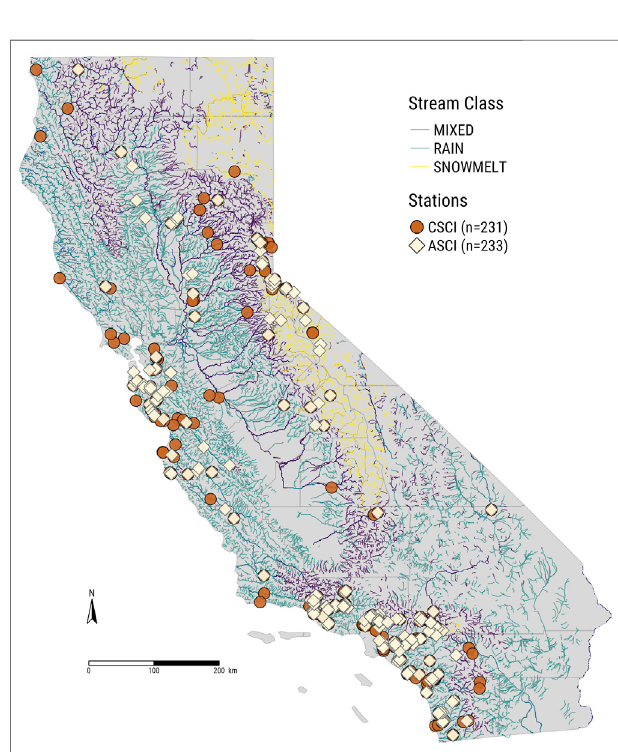
FIGURE3| MapofCalifornia showingselected biologicalsamplingsites for CSCI (circles, n (cid:1) 231) and ASCI (diamonds, n (cid:1) 233) data overlaying stream classi fi cations from Patterson et al.